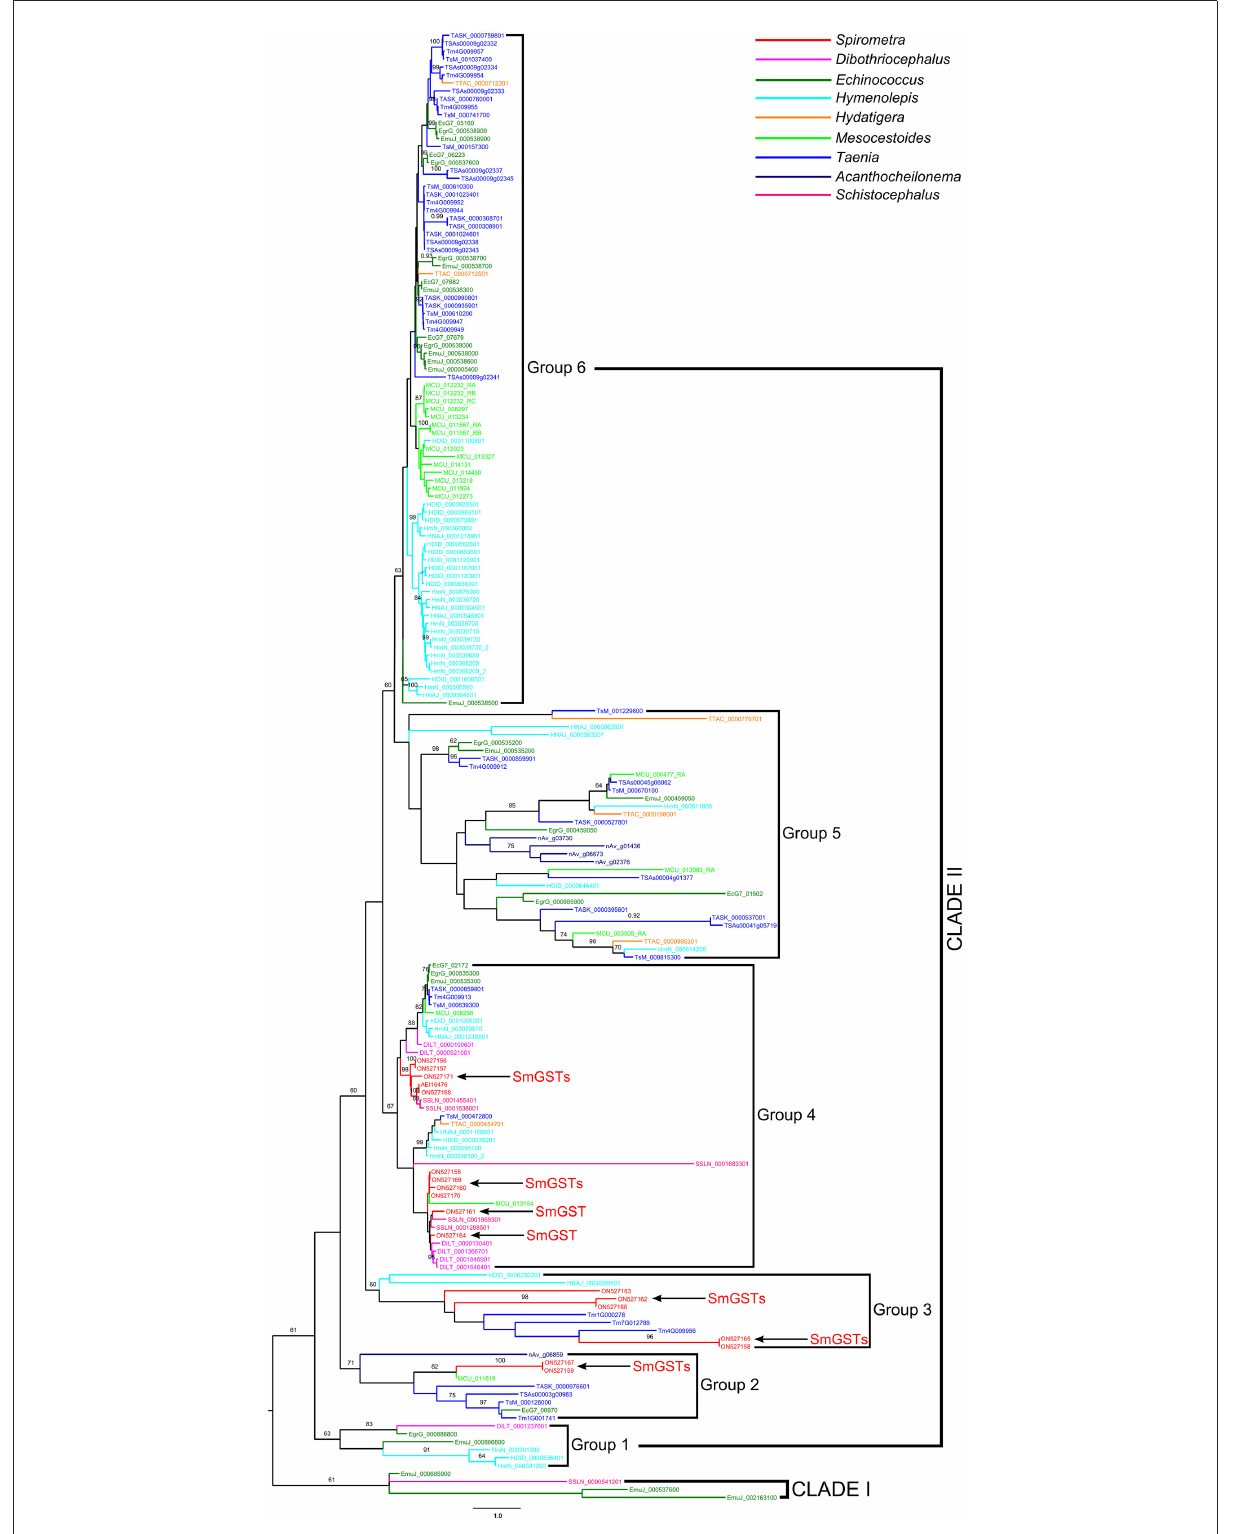
FIGURE6 Phylogenetic analysis of glutathione transferase sequences in selected medical cestodes based on maximum likelihood method. The numbers on the branches represent bootstrap values, and only values with bootstrap values > 60 are displayed.